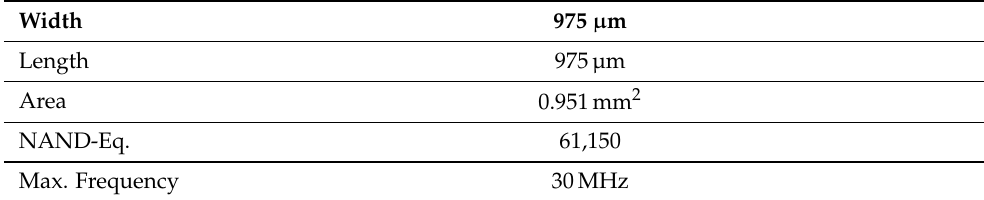
Table 6. Synthesis results for the ASIC in 180 nm technology. Width